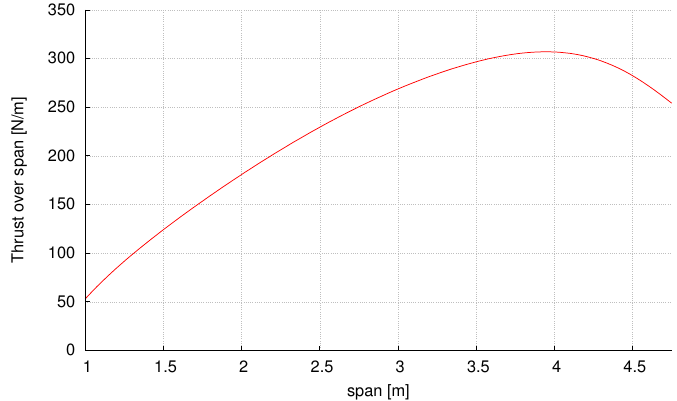
Figure 8. Spanwise production of thrust of the original NREL Phase VI blade from 1 to 4.75 m in radial